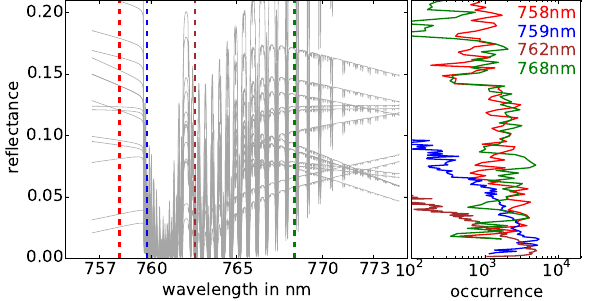
Fig. 1. The left panel illustrates the variability of the used spec- tral database by showing some randomly selected spectra. The right panel shares the reflectance axis with the left panel and shows log- arithmic histograms for four selected